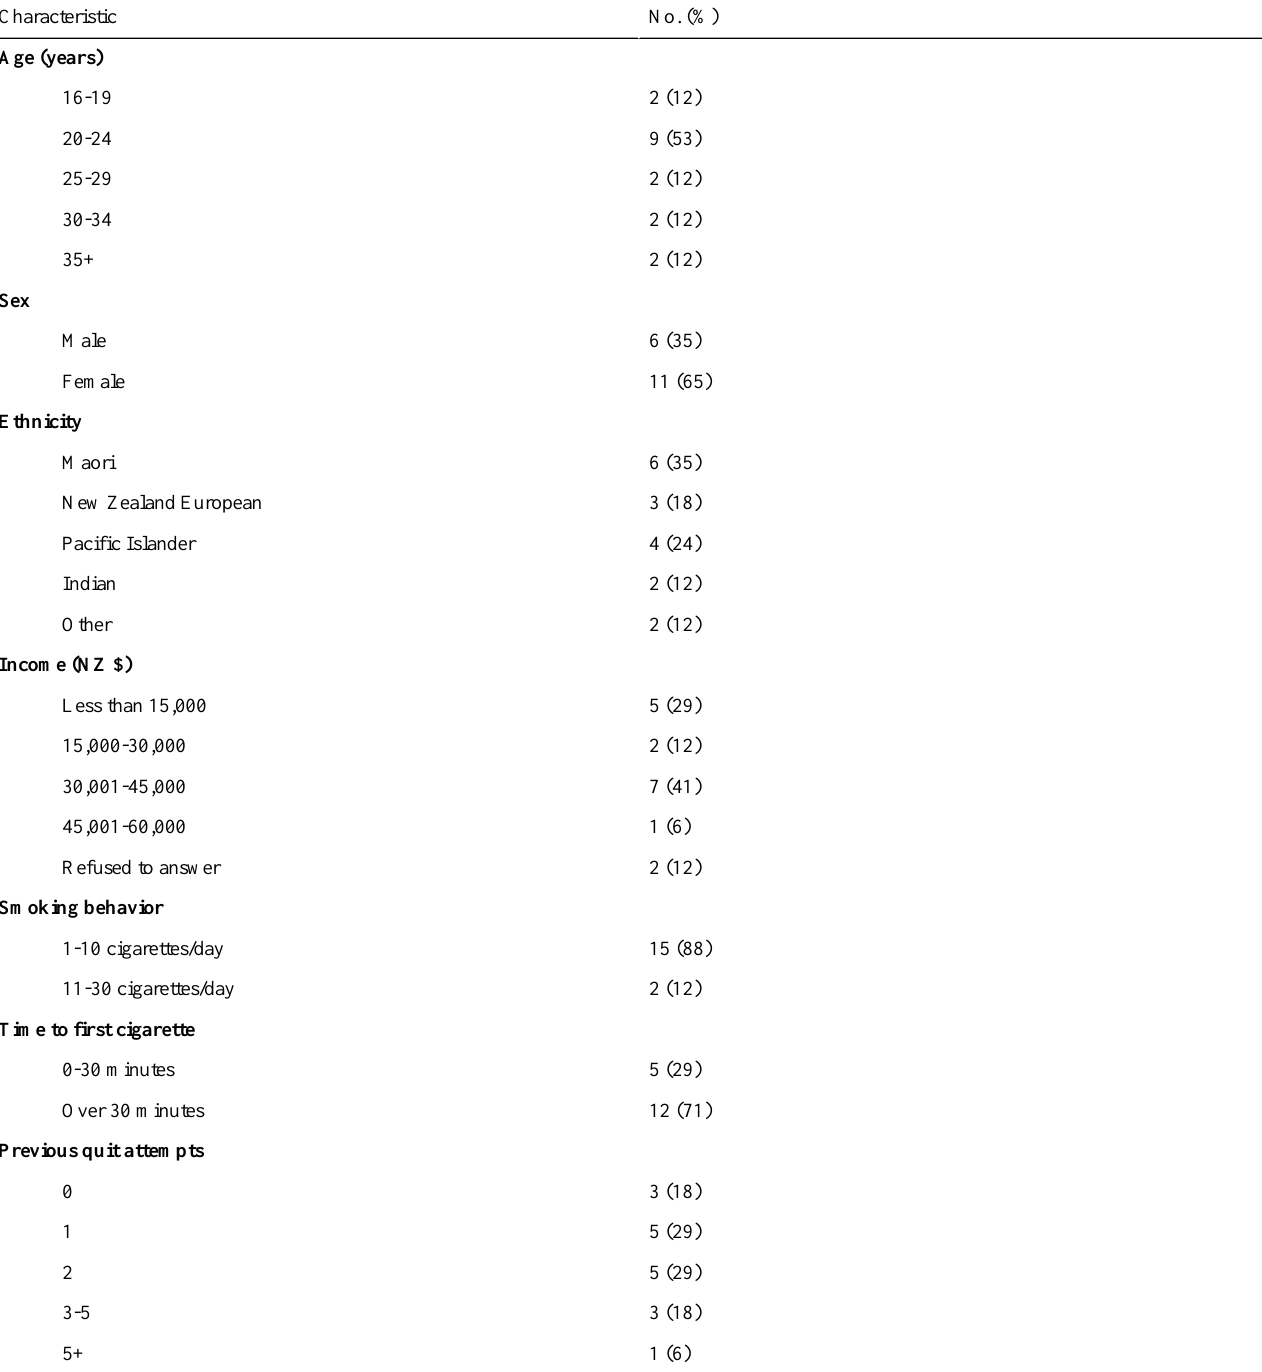
Table 3. Pilot study participant characteristics (N =